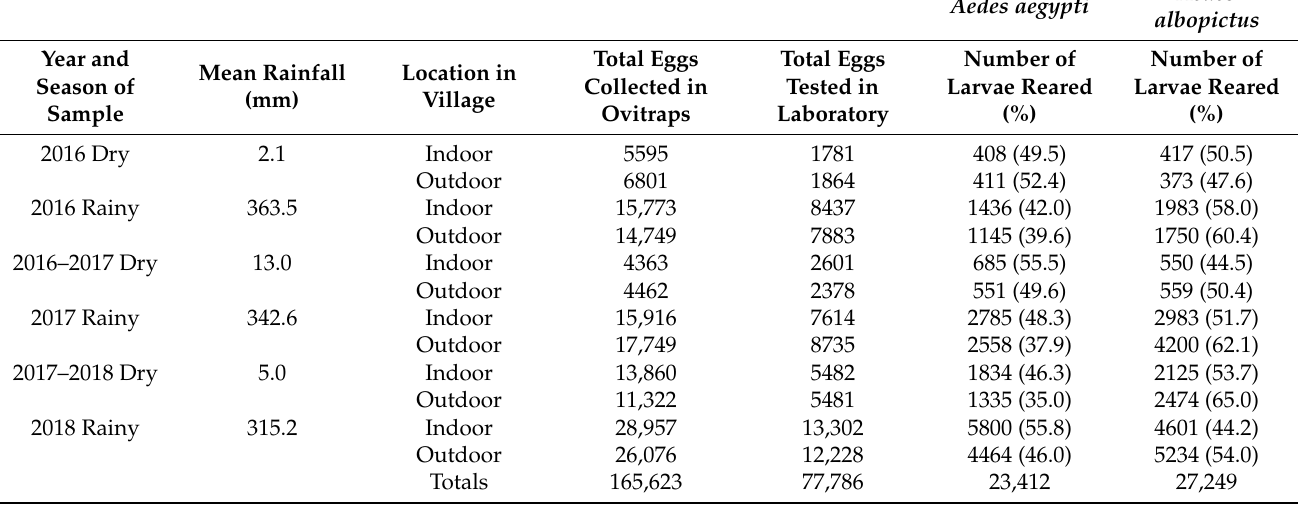
Table 1. Total number of Aedes spp. eggs collected from indoor and outdoor ovitraps in R í o Florido, number of eggs used for laboratory hatching and rearing studies, and prevalence of Aedes aegypti and Aedes albopictus determined by laboratory rearing from January 2016 to November